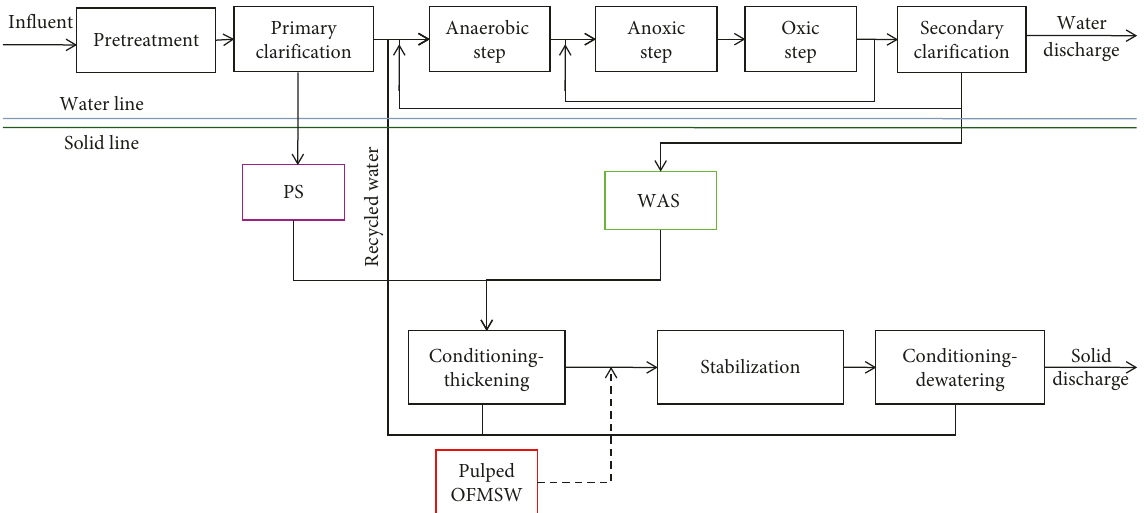
Figure 1: Adopted configuration for water and solid line simulation. Table 1: Characteristics of wastewater based on the Valladolid WWTP (Spain) and